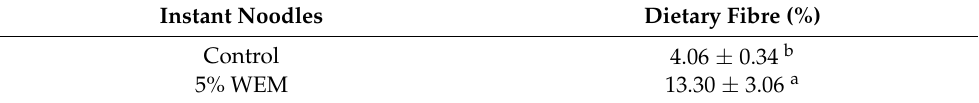
Table 2. The dietary fibre of noodles incorporated with WEM and without WEM (control).